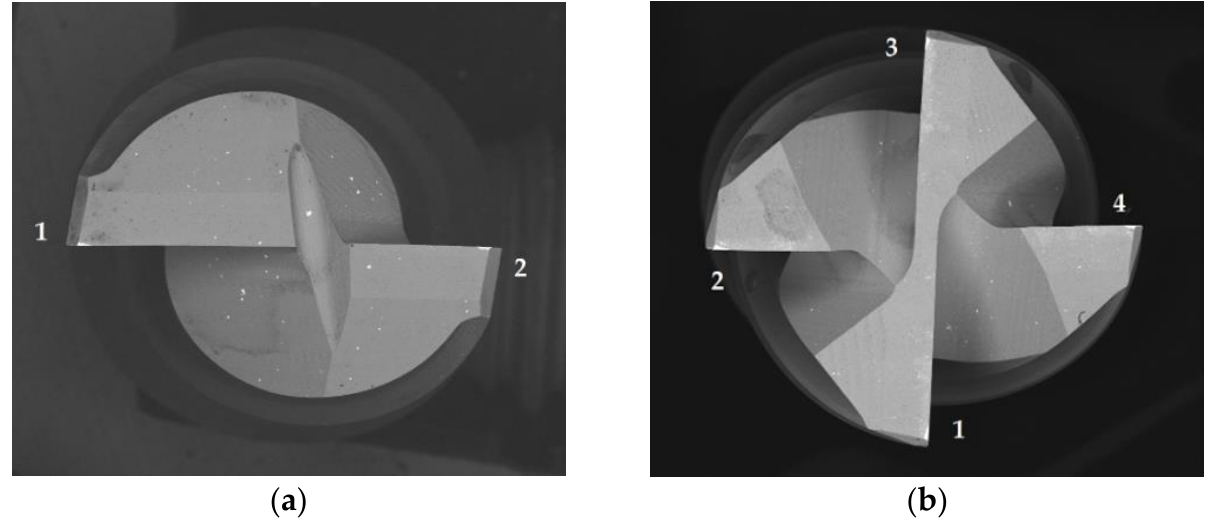
Figure 1. Reference used for the SEM analysis of the end-mills with ( a ) two cutting edges, and ( b ) four cutting edges.